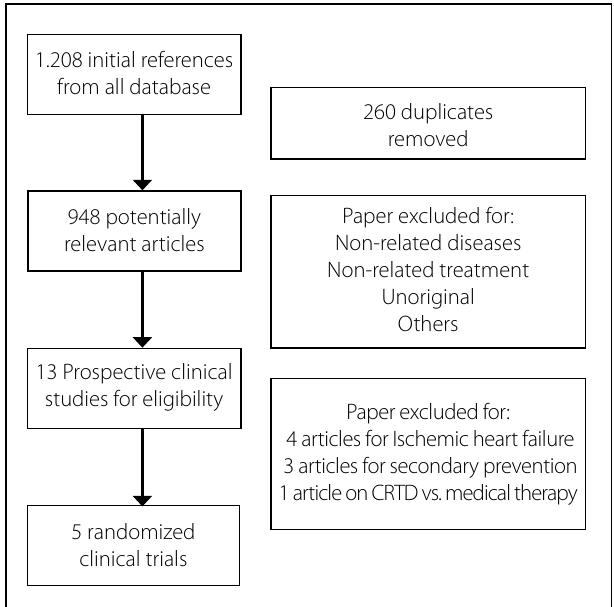
Fig. 1 - Flow diagram of literature searched for these